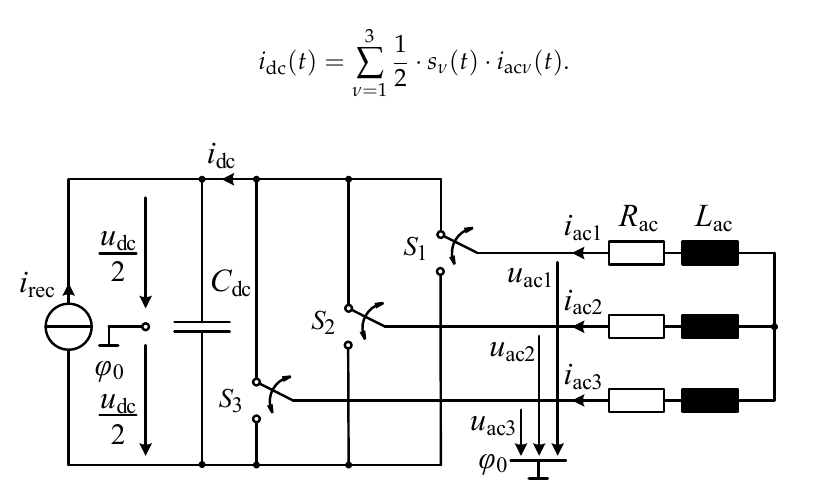
Figure 2. Equivalent circuit of the three-phase two-level